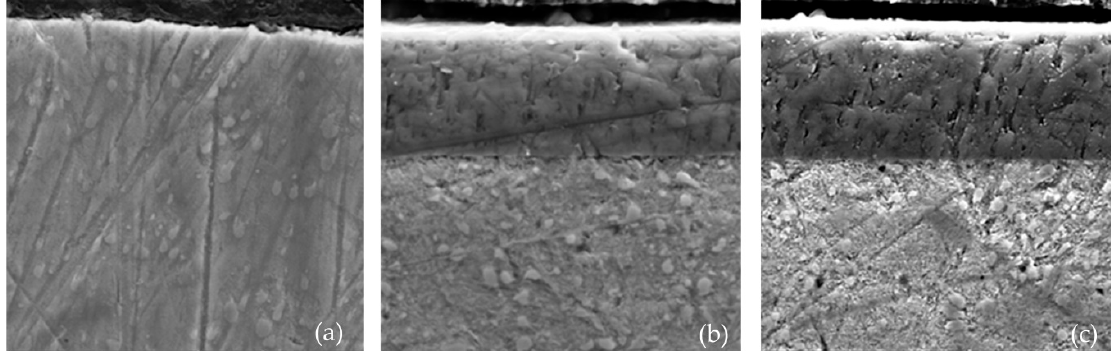
Figure 7. SEM images ( × 7000) of the microstructure of the reamers made of high-speed steel: ( a ) without coating; ( b ) TiN coated; ( c ) after combined surface strengthening.